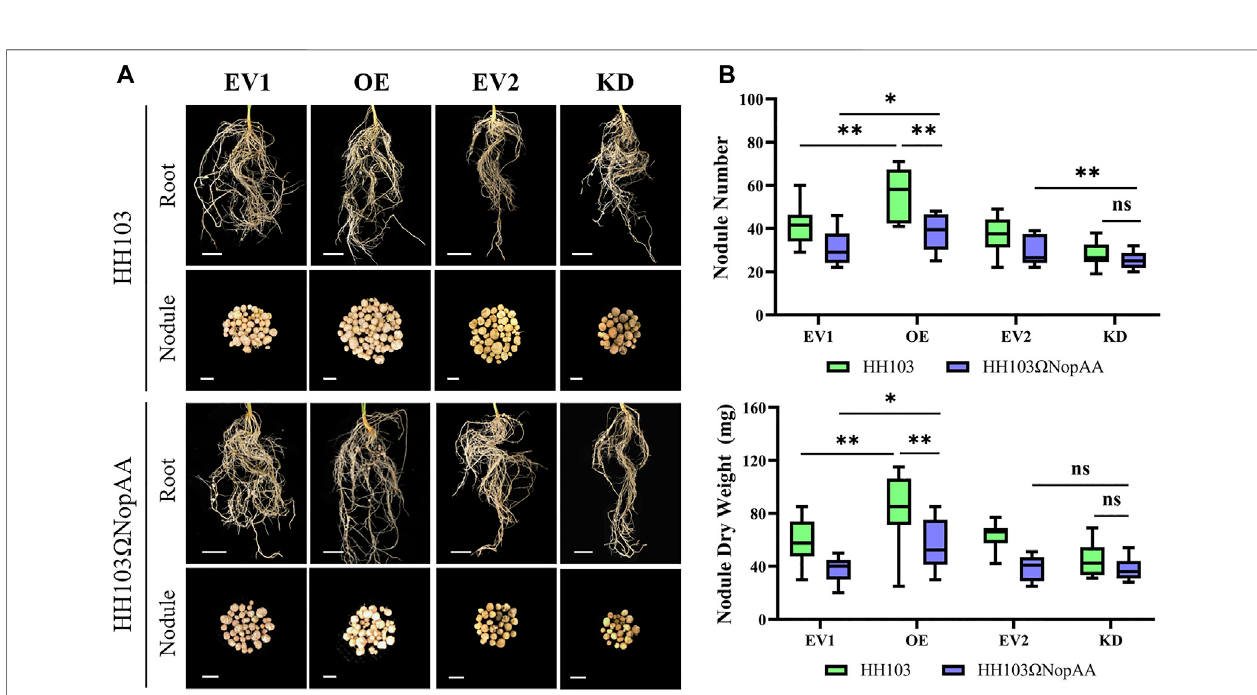
FIGURE 4 | Nodule phenotypes of EV1, OE, and KD. (A) Nodular phenotypes of hairy roots transformed with EV1, OE, EV2, and KD after inoculation with HH103 and HH103 Ω NopAA (28 dpi). EV1, Empty vector for gene overexpression; OE, Overexpression of GmARP ; EV2, Empty vector for gene silencing; KD, Gene silencing of GmARP by RNAi. Root: scale bars represent 1 cm; nodule: scale bars represent 2 mm. (B) Boxplots of nodule phenotypes. Data are presented as the average of three different biological replicates and 15 plants for each replicate and signi fi cance was determined by t -tests.